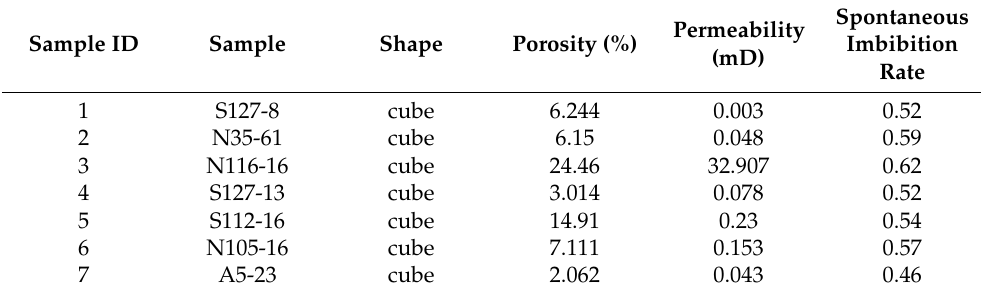
Table 6. Spontaneous imbibition rate of 7 samples.